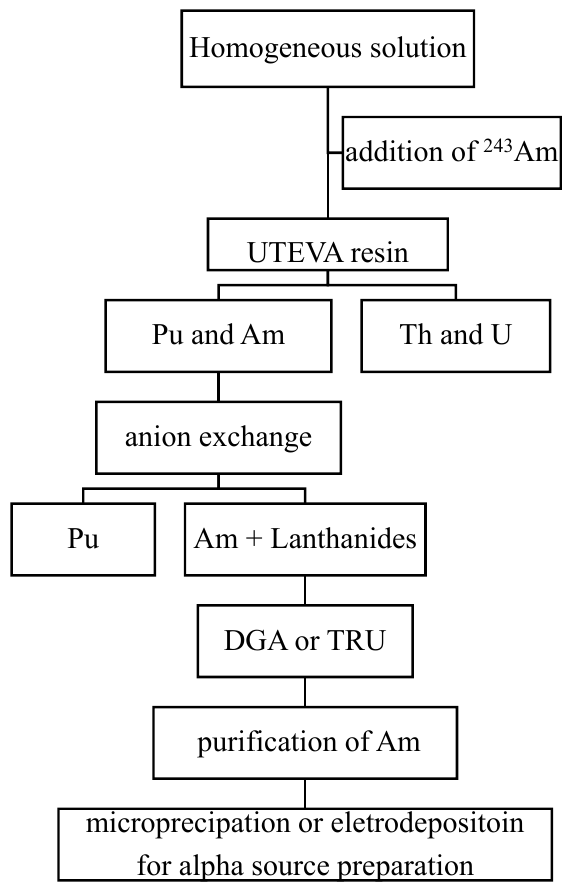
Figure 1. Scheme of a combined procedure for the determination of 241 Am from an aqueous solution.